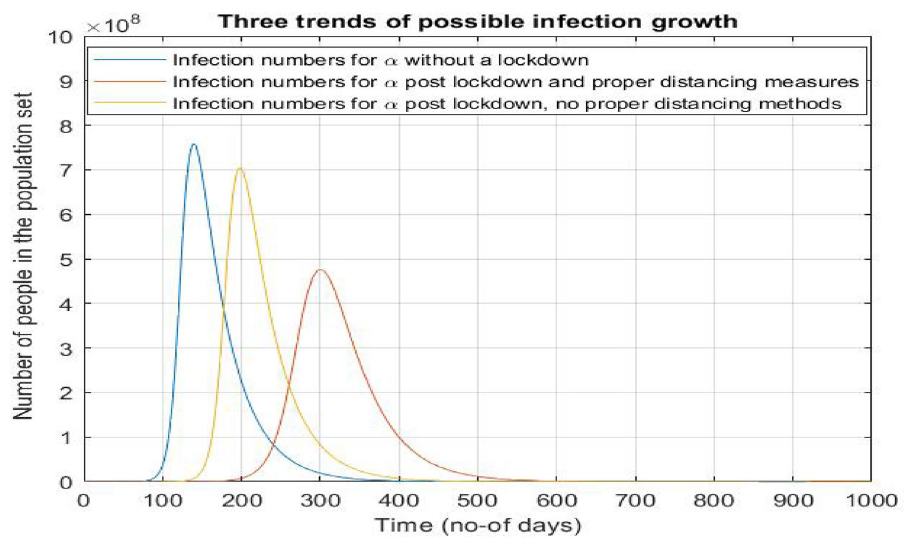
Figure 11. Analysis of number of infections upon various scenarios of lockdown. It can be observed that the number of cases at the peak almost halves with a distinct shift in the abscissa of peak, when the lockdown continues. When lockdown is removed all of a sudden (and assumed that the α = 0.165 , just like the value before lockdown), there is less decline in the number of cases at the peak with a subtle shift in the abscissa of peak.